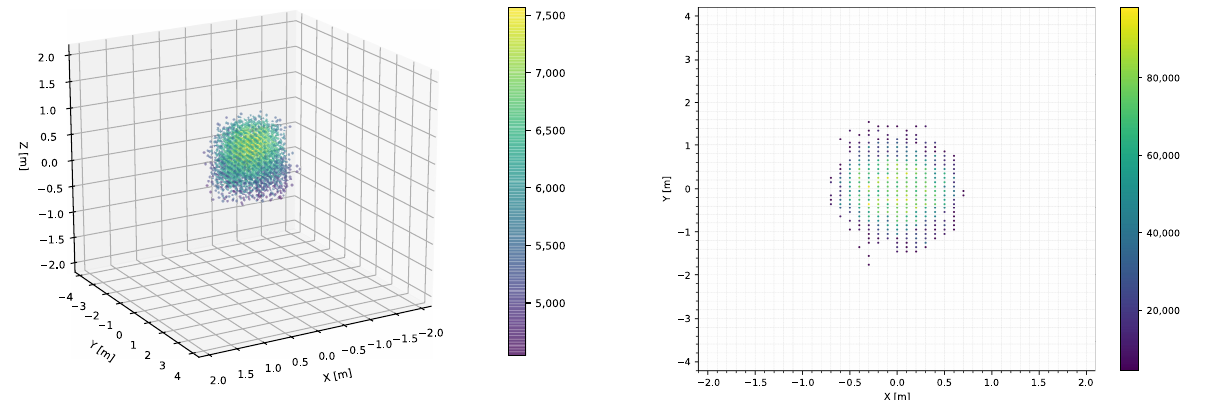
Figure 13. The 3D voxel map of the lead block in the water basin ( left ) and its 2D projection ( right ) reconstructed with the parameter set optimized for lead block in water basin as shown in Table 5. The color of the voxel point represents the combined voxel score s comb